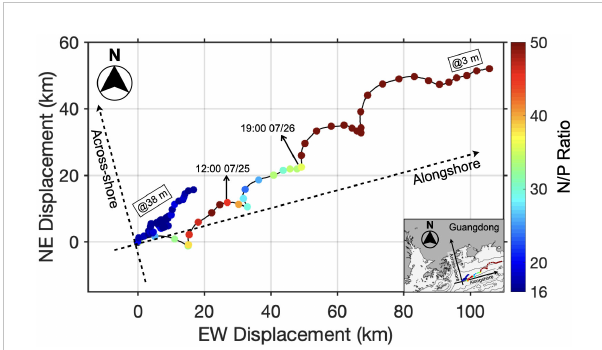
FIGURE 2 The progressive vectors (PVs) at the surface (3 m) and bottom (38 m). The N/P values (range indicated by the color bar to the right) are superimposed to indicate the sequential change of nutrient composition of the water mass. The marked time points indicate the duration having low N/P within the storm in fl uence. The dashed arrows show the positive alongshore and across-shore directions. The PVs are plotted on a small-scale map (insert) to give a regional